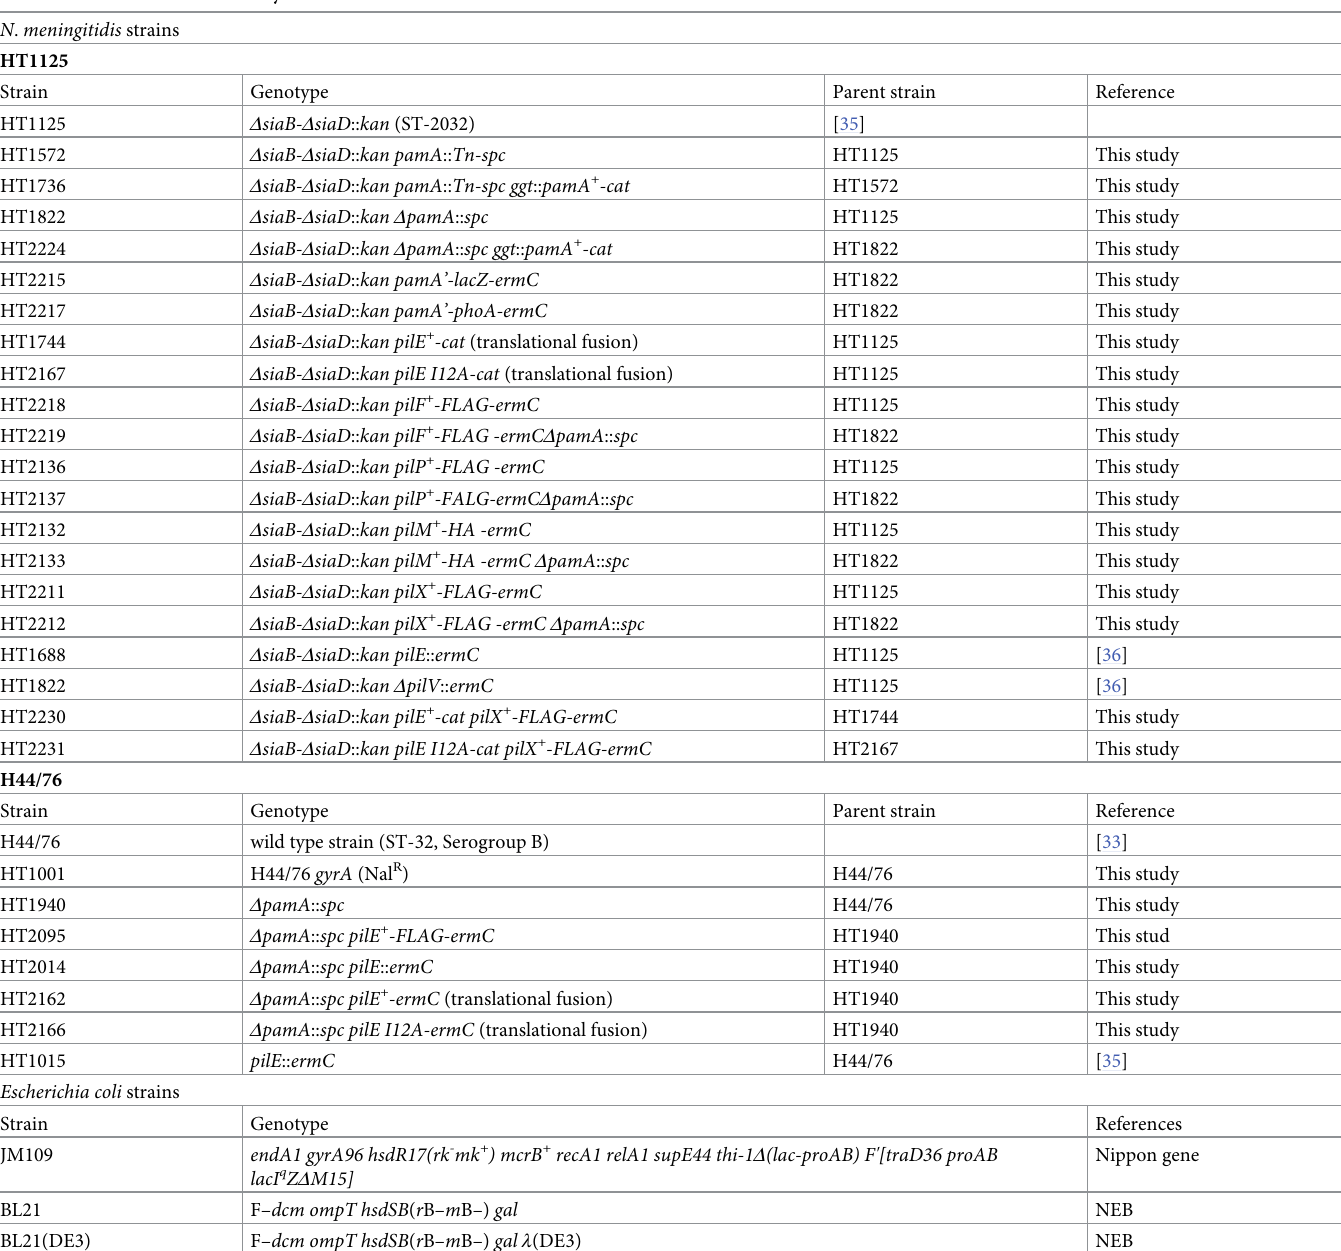
Table 2. Strains used in this